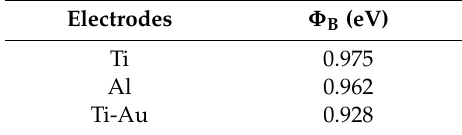
Table 2. The barrier heights of Ti, Al, and Ti-Au electrodes to n-type (111) CdZnTe crystals.